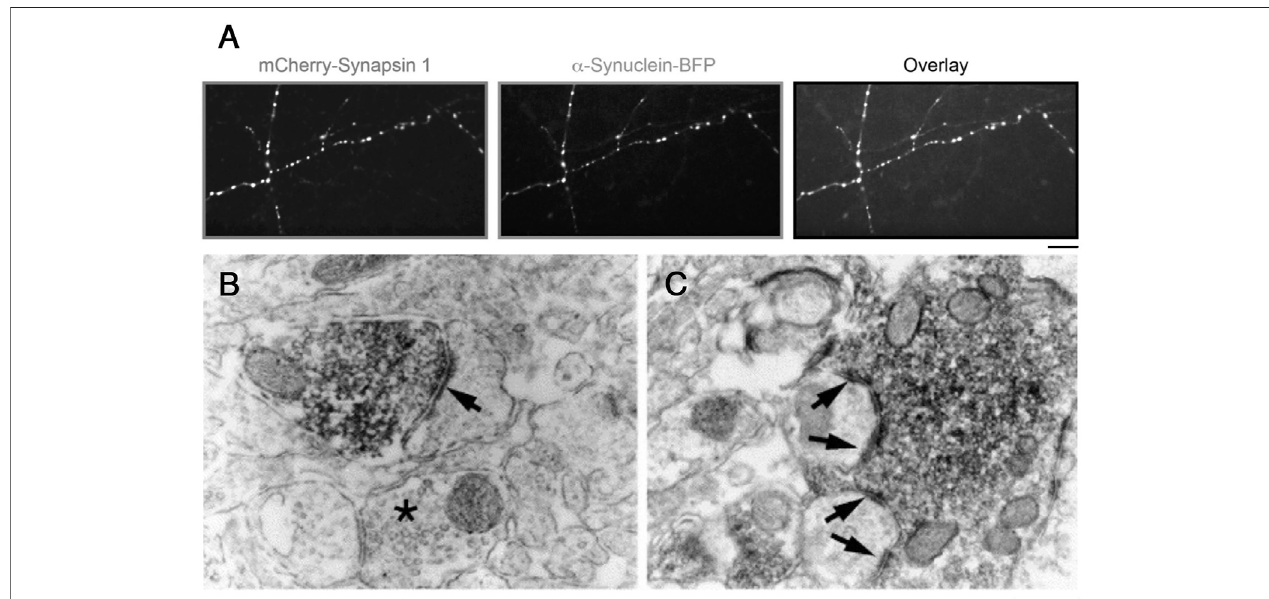
FIGURE 1| Accumulation of α -synuclein and synapsin in SVclusters. (A) mCherry-synapsin Iand α -synuclein-BFP constructs are targeted to synapses in primary hippocampal neurons. Heterologous expression ofmCherry-Synapsin I. Scale: 10 µm.From (Hoffmann et al., 2021). (B,C) Electron microscopic images ofsymmetrical synapticcontacts (arrows) intheprefrontal cortex (B) and hilus (C) labeled withanti- α -synuclein antibodies. Note anaccumulation ofthesynuclein labeling oversynaptic vesicle clusters. Scale: 0.3 µm. From (Totterdell et al.,